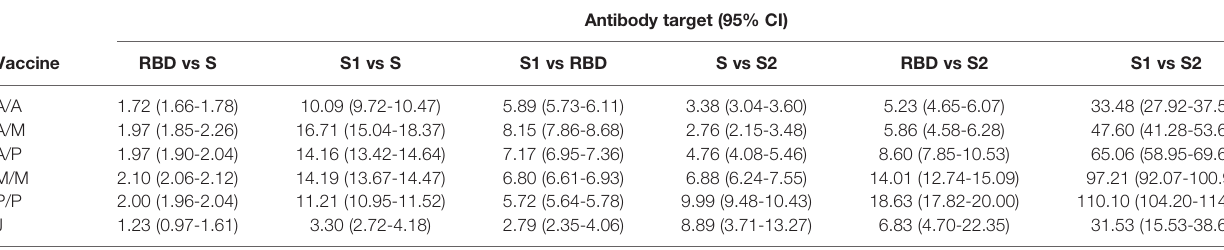
TABLE 3 | Antigen-speci fi c ratios for different vaccination schemes.